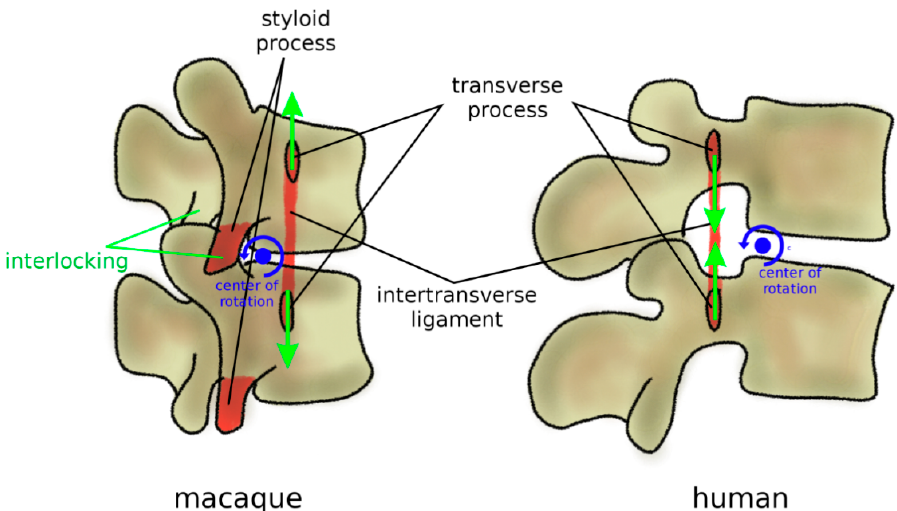
Figure 8. Anatomical protection mechanisms to avoid hyperextension in mammal quadrupeds and non-bipedal primates (macaque, left) in comparison with humans (right). Ventral transverse processes determine tensile stress in the intertransverse ligament in extension, which limits the vertebral rotations. Lumbar vertebrae commonly possess a styloid process which acts as an osseous block to facet sliding in extension. In humans, these protection mechanisms were lost; transverse processes are dorsally located, and the styloid process is absent. Furthermore, facet joints have fewer encompassing shapes and do not strongly interlock in extension.